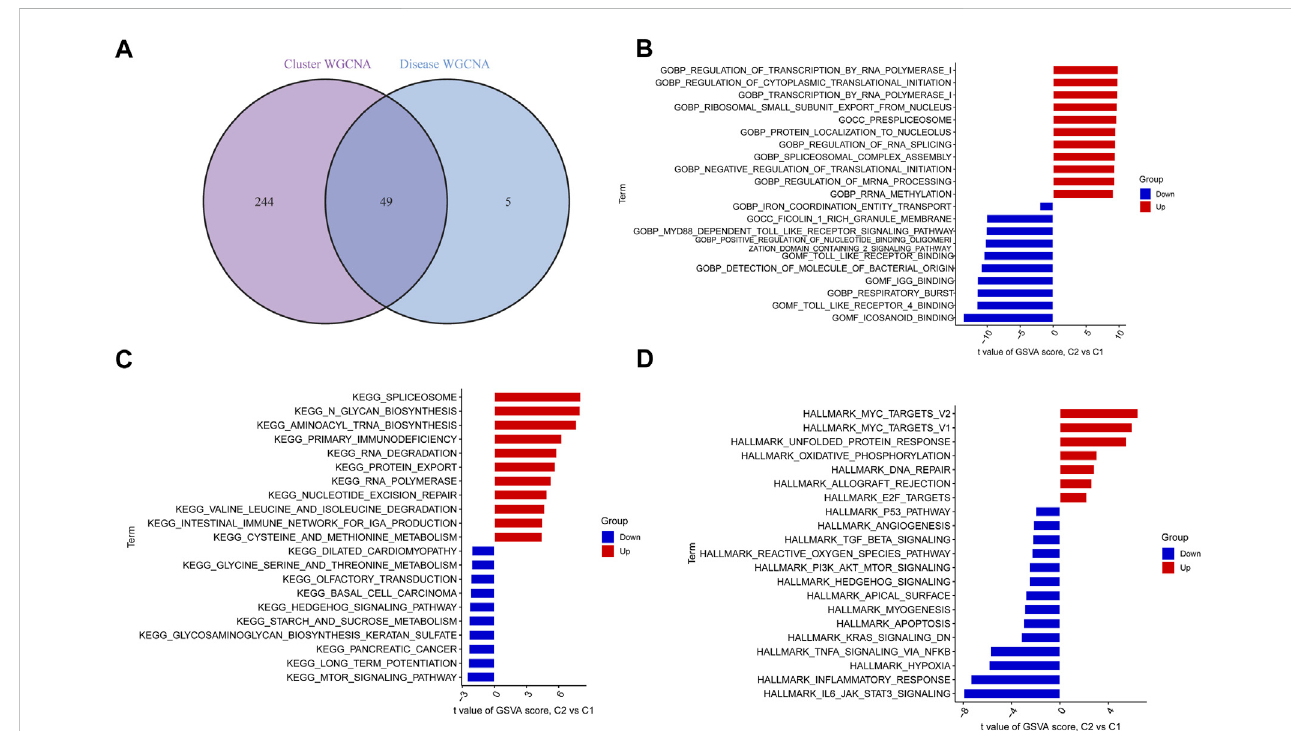
FIGURE 7 Identi fi cation of cluster-speci fi c DEGs and biological characteristics between two ER stress clusters. (A) The intersections between module-related genes of ER stress clusters and module-related genes in the GSE32472 dataset. (B – D) Differences in GO pathway, KEGG pathway, and hallmark pathway between cluster 1 and cluster 2 samples ranked by t -value of GSVA